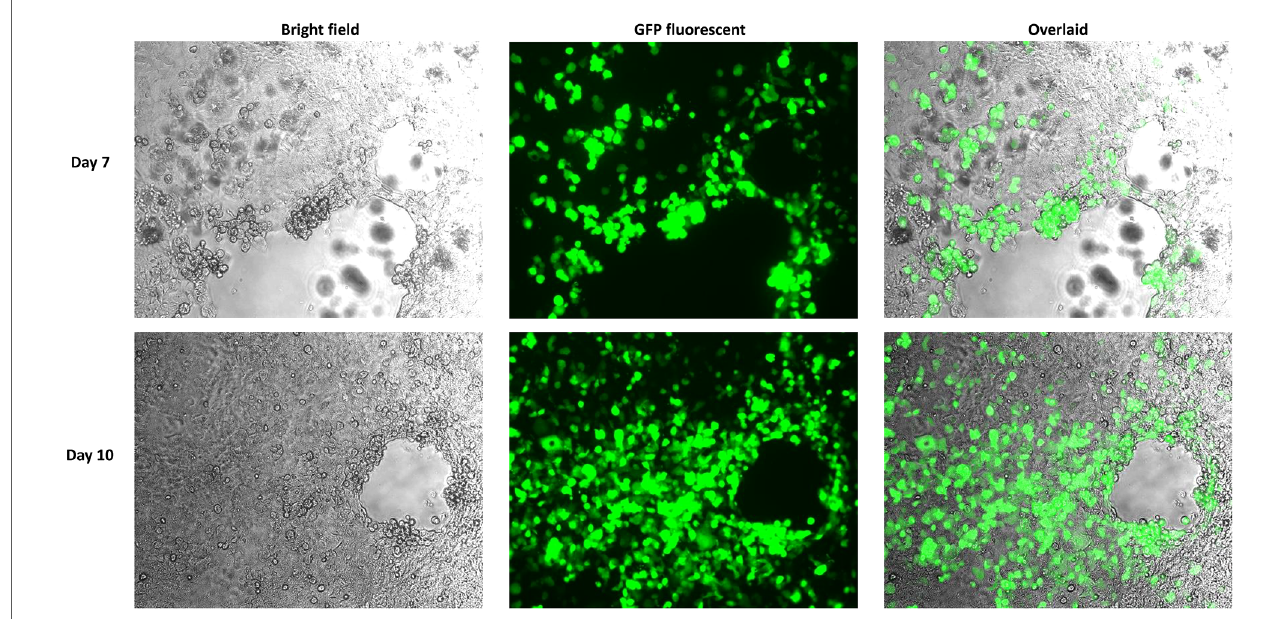
FIGURE 4 GFP fl uorescent imaging of AD293 cells on days 7 and 10 post transfection with the linearized rAdV14 genome. AD293 cells were seeded on a 6-well plate one day prior to transfection with the linearized rAdV14. The culture medium was replaced with a fresh preparation on days 3, 5, and 7, and GFP fl uorescent images were taken 7 and 10 days post-transfection. The cytopathic effect caused by the adenovirus replication (bright fi eld) and the expression of the GPF ( fl uorescent) are colocalized as can be seen in this overlaid image.